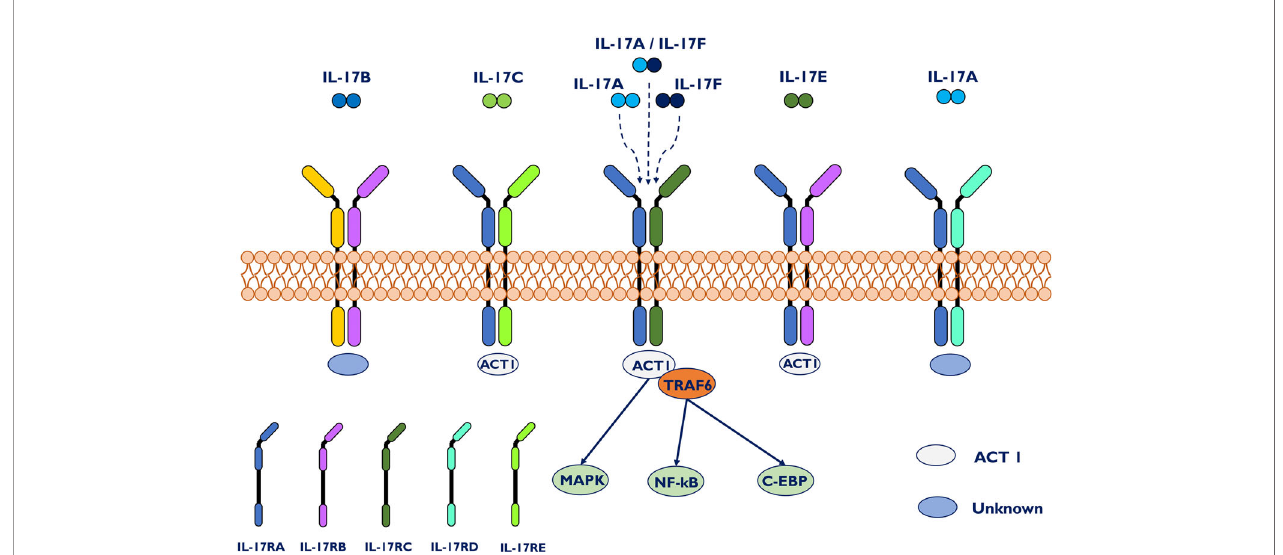
FIGURE 1 | IL-17 family, IL-17 receptors and signal transduction. The IL-17 family is composed of six homologous dimeric proteins (IL-17A to F), while the receptor family consists of fi ve members, IL-17RA to E. IL-17A and IL-17F bind either as individual homodimers or as a heterodimer to a dimeric IL17RA – IL17RC complex. Act1 has been shown to be the key signal-transducing molecule downstream of IL17RA and C, recruiting TRAF6 to further trigger downstream signaling pathways. Act1 has also been identi fi ed in IL-17C- and IL-17E-mediated signaling. Speci fi cally, IL-17RA/RD acts only as a receptor for IL-17A/A. IL-17C associates with IL17RA/E, whereas IL-17E binds to